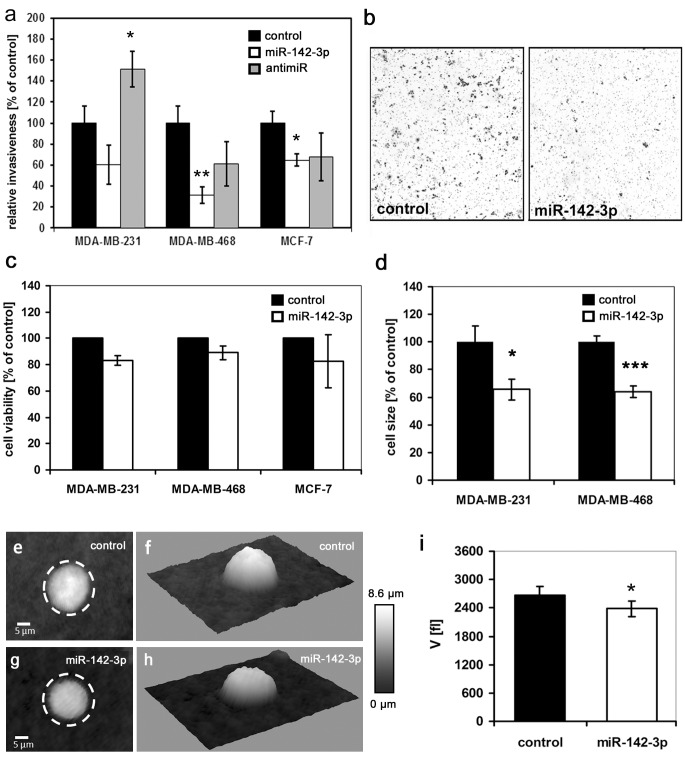
Functional analysis of miR-142-3p upregulation on invasiveness, viability and size of MDA-MB-231, MDA-MB-468 and MCF-7 breast cancer cells.Cells were transfected with a control miRNA, miR-142-3p or antimiR-142-3p as described in the methods section. (a,b) Matrigel invasion assay (BD Biosciences, Heidelberg, Germany) was performed as previously described [9,10]. miR-142-3p significantly inhibited breast cancer cell invasiveness by 39% and 32% in MDA-MB-468 (24h) and MCF-7 cells (48h) respectively. In MDA-MB-231 cells, anti-miR-142-3p caused a significant increase in invasiveness of more than 50%. Error bars = s.e.m (n≥6, *P<0.05, ***P<0.01). (b) Right panel: representative micrographs of invasion filter membranes after crystal violet staining (MDA-MB-468). (c) MTT assay reveals no significant effect of miR-142-3p on cell viability. MDA-MB-231, MDA-MB-468 and MCF-7 cells transfected with miR-142-3p precursors or a control miR precursor were allowed to proliferate for 72h. Error bars = s.e.m., n≥3. (d-i) miR-142-3p upregulation reduces cancer cell diameter and volume. (d) The two-dimensional size [μm3] of transfected MDA-MB-231 and MDA-MB-468 cells revealed a significant decrease in size upon miR-142-3p upregulation. N>70, error bars = SEM, *P<0.05, ***P<0.01. (e-i) Digital holographic microscopy (DHM) of miRNA transfected MDA-MB-468 cells reveals decreased cell volume after miR-142-3p transfection. (e,g). Representative quantitative DHM phase contrast images of suspended transfected MDA-MB-468 cells (g) and control cells (e) (coded to 256 gray levels); the dashed circles illustrate the cell volume increase. (f, h) pseudo-three-dimensional representations of the phase images in e, g correspond to the projection of the cell thickness. (i) cell volume V of n = 251 miR-142-3p transfected cells appears significantly decreased in comparison to the volume of n = 172 control cells; Data are mean ± SEM, *P<0.05, ***P<0.001.